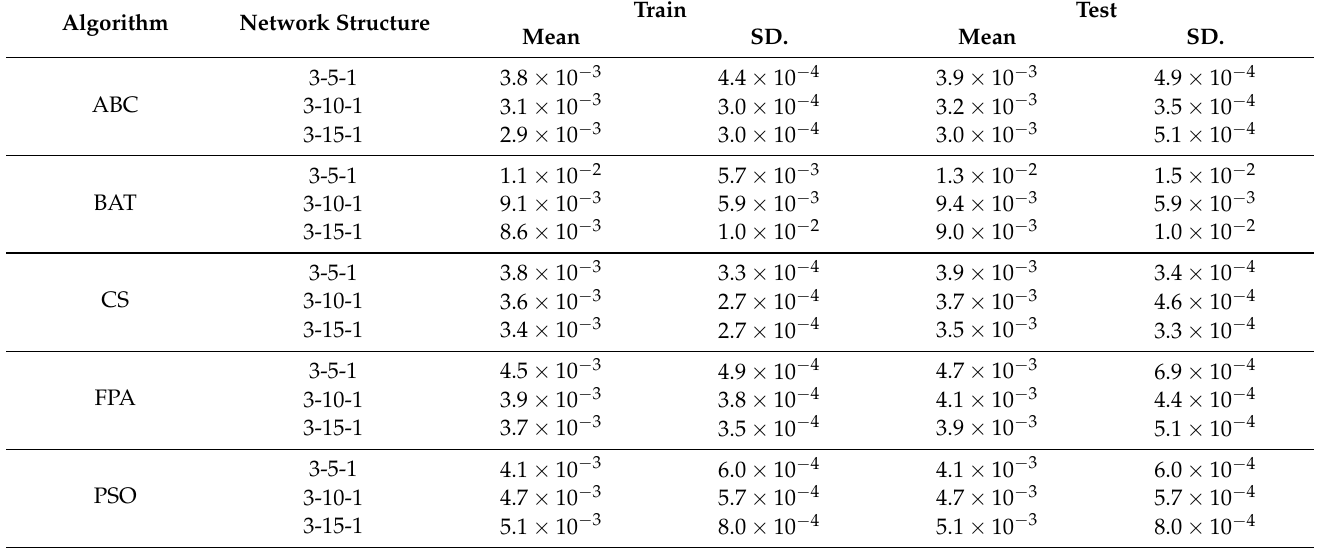
Table 7. The results obtained by using the metaheuristic algorithms for D 2